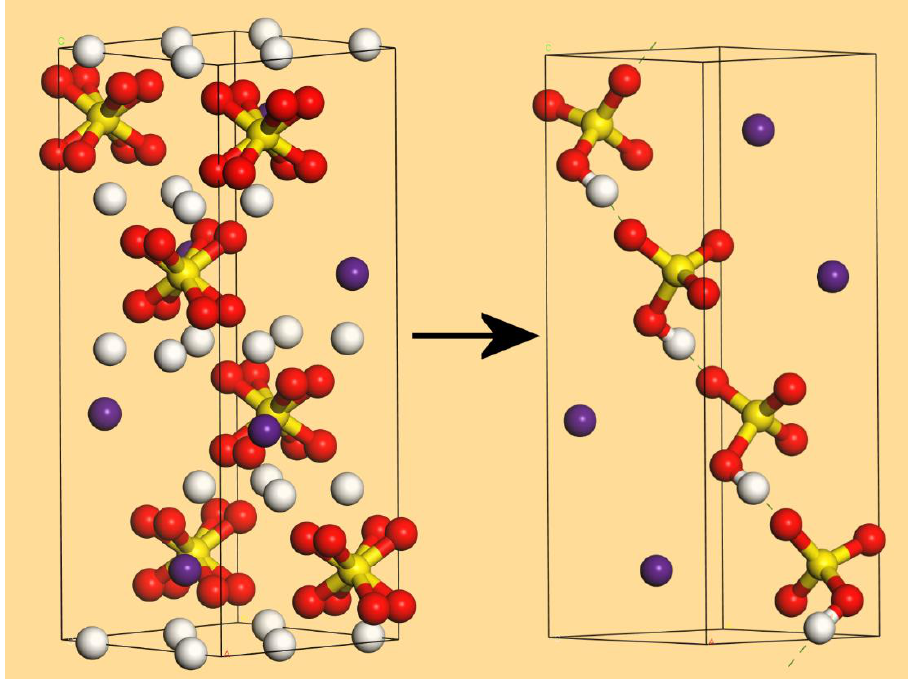
Figure 8. Left: the structure of CsHSO 4 in phase I by Jirak et al . [9]. Right: the structure after choosing one orientation of the sulfate ion and geometry optimisation. (White = hydrogen, red = oxygen, yellow = sulfur, purple = caesium).